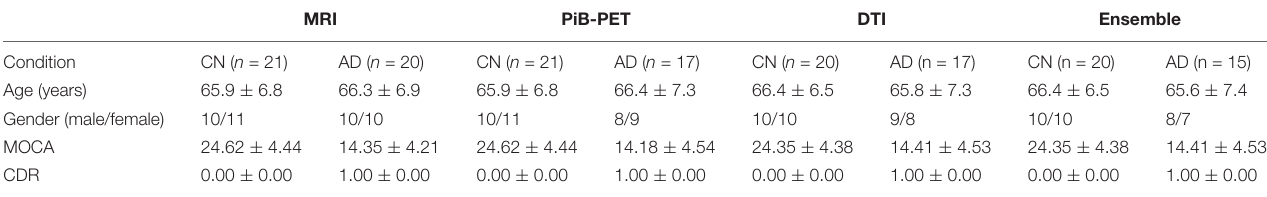
TABLE 1 | Demographics and neuropsychologic characteristics for the study population. MRI PiB-PET DTI Ensemble